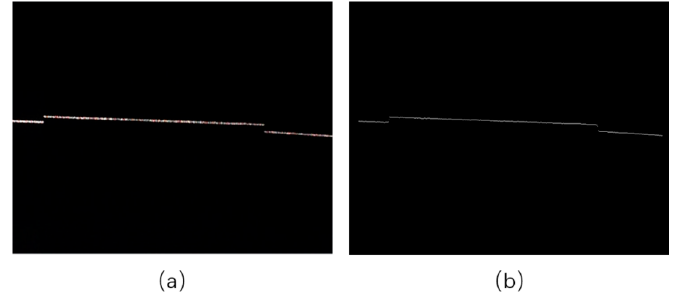
Figure 14. ( a ) Image captured by camera; ( b ) skeleton.